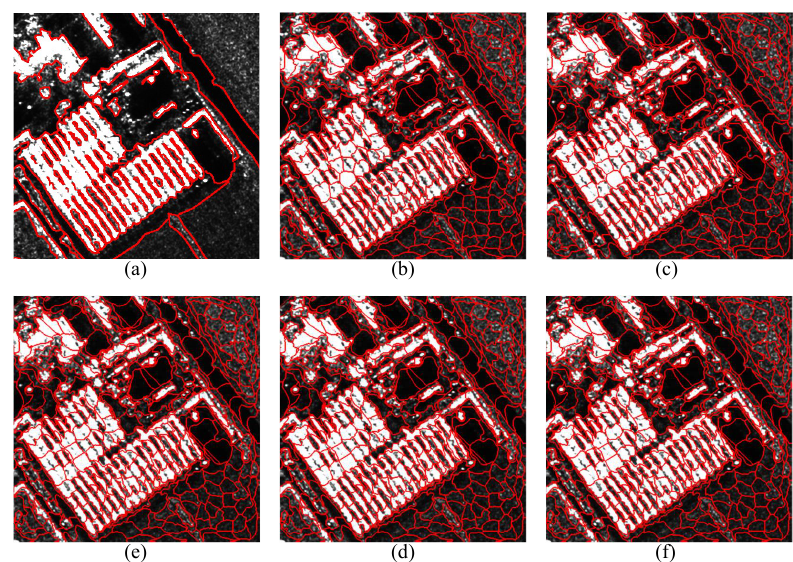
Figure 9. Superpixel generation results with different v . ( a ) Ground truth. ( b ) v = 5. ( c ) v = 10.